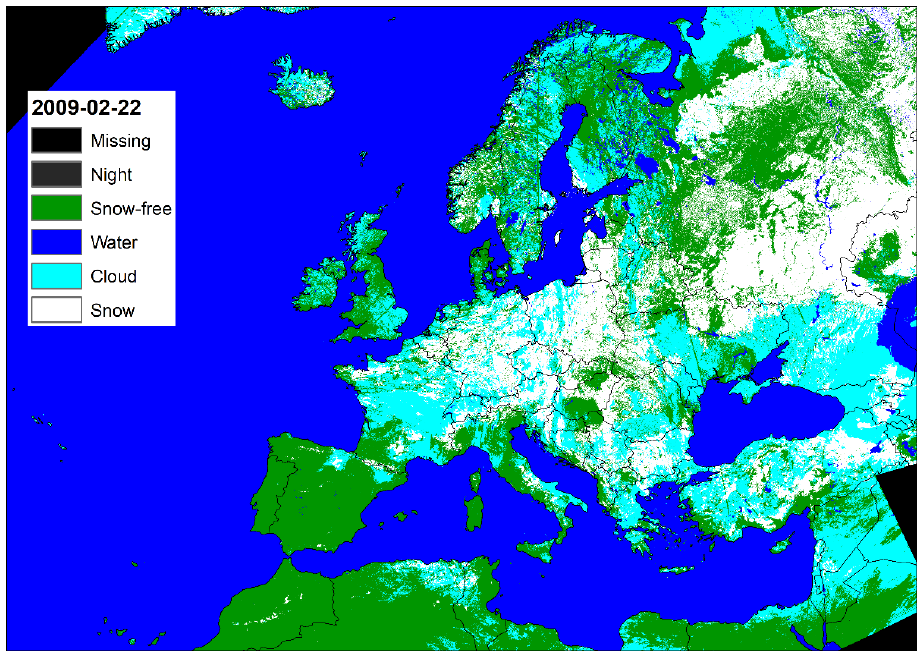
Figure 7. Example of a Daily Level 3 product for 22 February 2009 (maximum snow coverage).